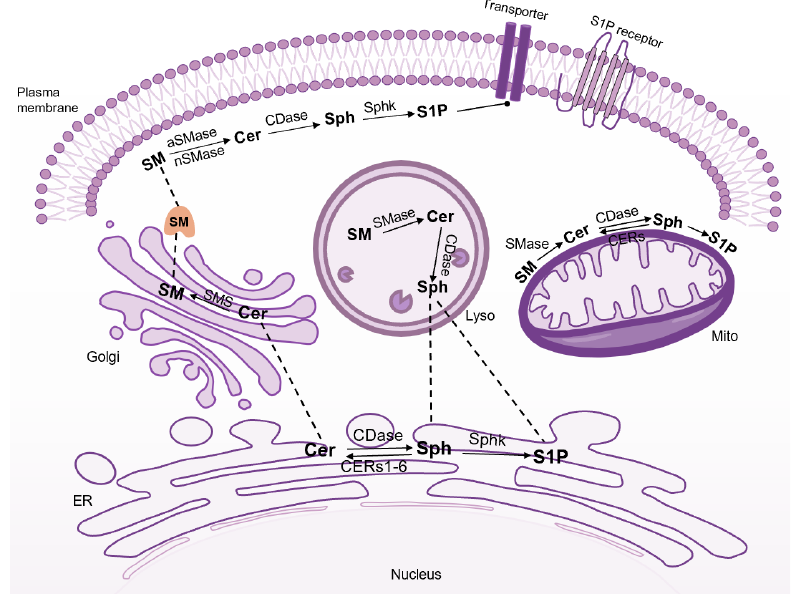
Figure 2. Intermediates involved in the three synthesis processes of ceramide that have the potential to be developed into drug targets. The ceramide de novo synthesis pathway occurs in the endoplasmic reticulum (ER), and is subsequently transported via the ceramide transport protein (CERT) or vesicles to the Golgi apparatus, where ceramide can be metabolized to other types of sphingolipids.